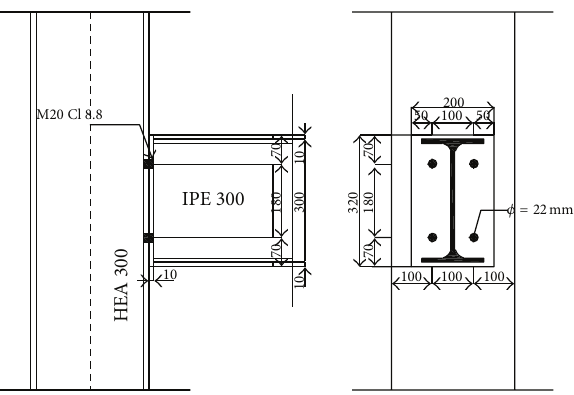
Figure 3: Details of the rigid connection with end plate.